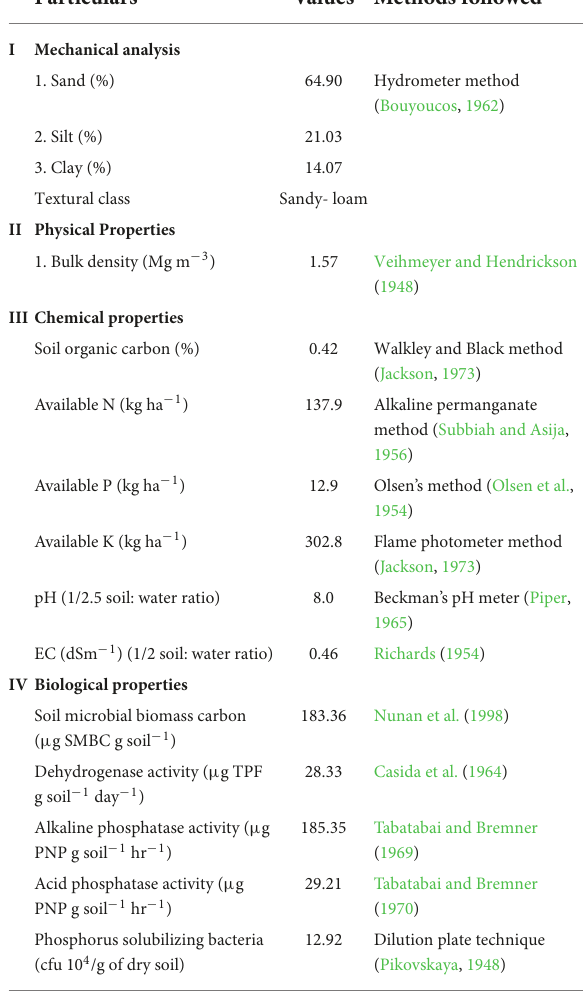
TABLE 1 Physico-chemical and biological properties of the soil at the start of